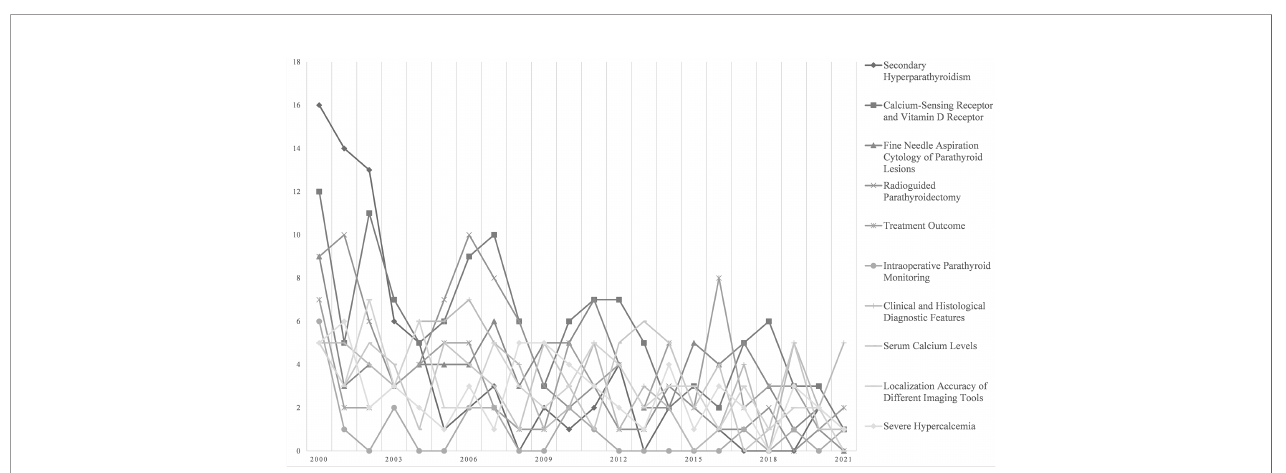
FIGURE 6 | Latent Dirichlet allocation (LDA) analysis: increase in topic area articles per year.